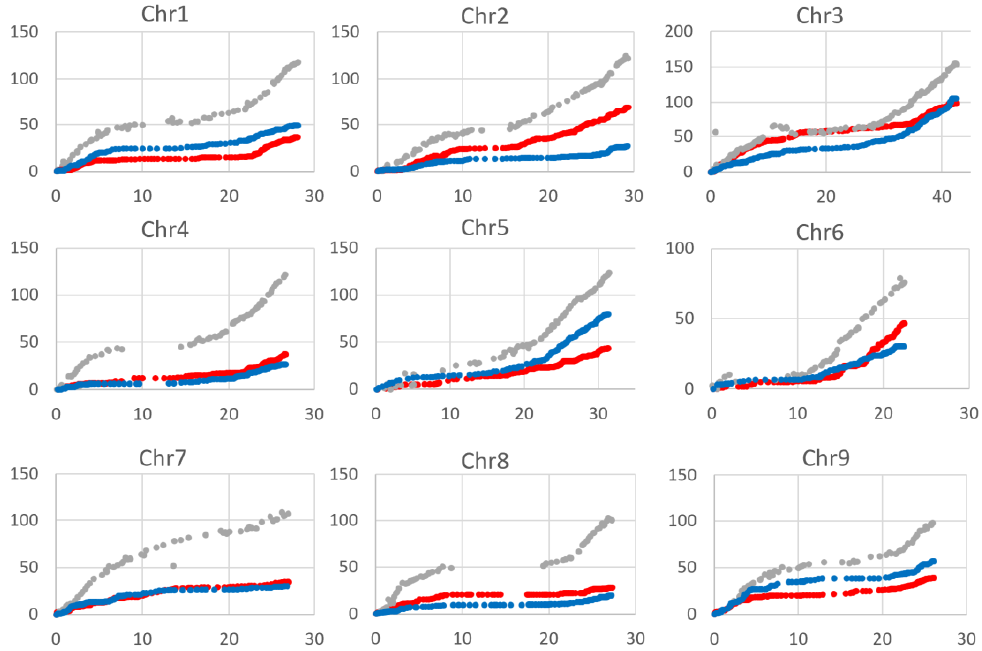
Figure 2. Marey map plot of the nine linkage groups of the Swingle citrumelo genetic map (red dot), Volkamer lemon genetic map (blue dot), and trifoliate orange reference genetic map generated in Huang et al. (2018; [59]) (grey dot). The x-axis represents the physical positions (in Mb) on the P. trifoliata reference genome (Peng et al. 2020; [58]), and the y-axis represents the position on each genetic map (in cM).